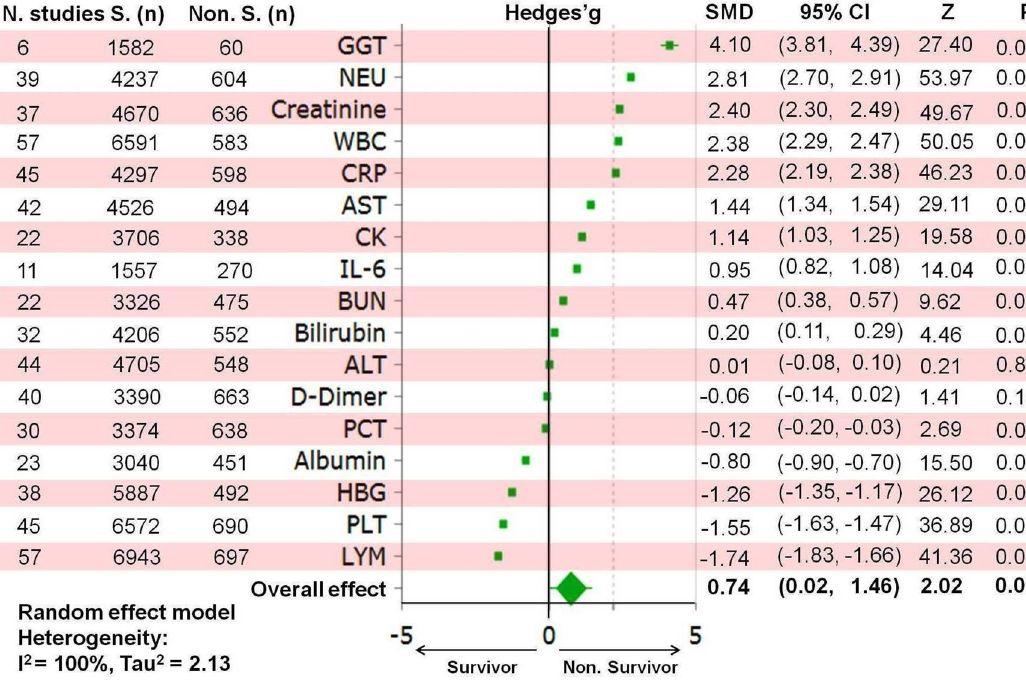
Figure 3. Forest plot of blood parameters in survivors and non-survivors of COVID-19. The Standardized Mean Difference (SMD) and the 95% confidence intervals (CIs) were used to define the effect size of different blood indices in survivors and non-survivors. S, survivors; GGT, gamma-glutamyl transferase; NEU, neutrophil; WBC, white blood cell; CRP, C-reactive protein; AST, aspartate aminotransferase; CK, creatine kinase; IL-6, interleukin-6; BUN, blood urea nitrogen; ALT, alanine aminotransferase; PCT, procalcitonin; HBG, hemoglobin; PLT, platelet; LYM, lymphocyte; n, population size.